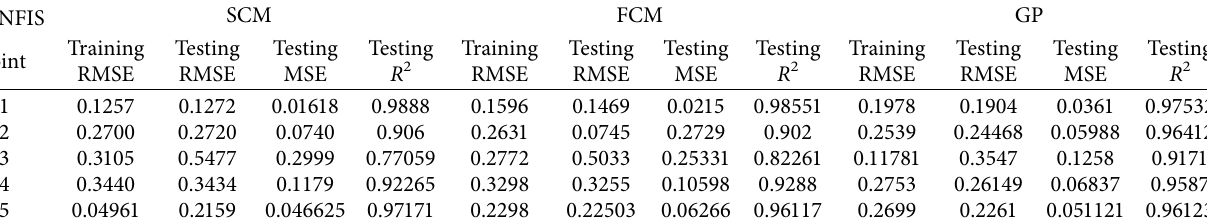
Figure 7: Applied MANFIS structure. Table 3: Results of ANFIS models (RMSE